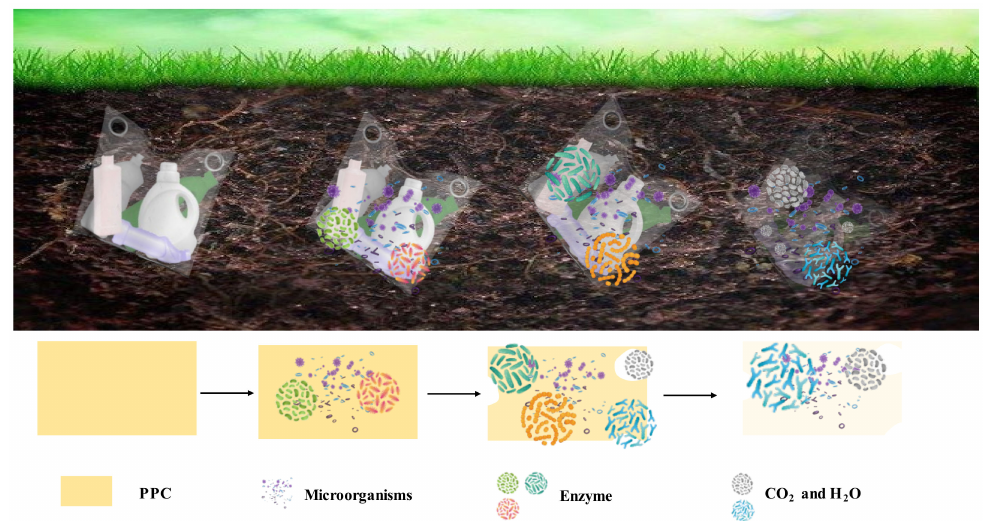
Figure 6. Biodegradation of plastics in natural environments